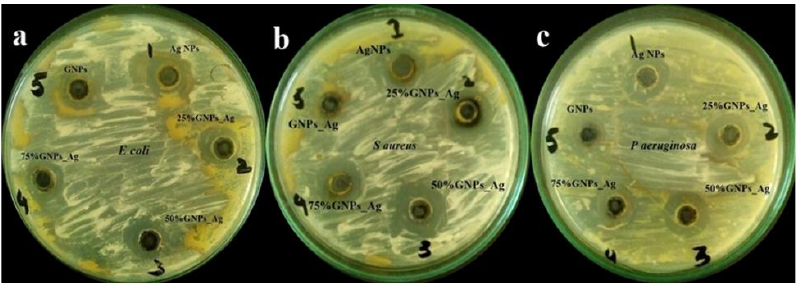
Figure 7. Zone of inhibition (ZOI) generated by (Ag) 1−x (GNPs) x in ( a ) E. coli, ( b ) S. aureus and ( c ) P. aeruginosa .